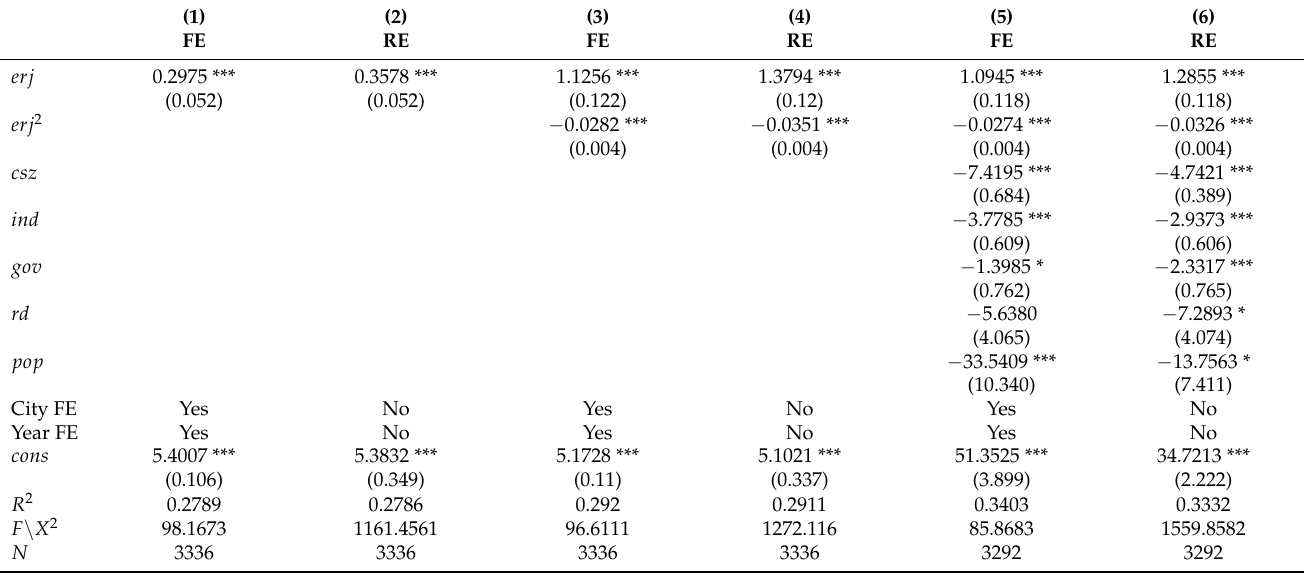
Table 4. Impact of energy inputs on CO 2